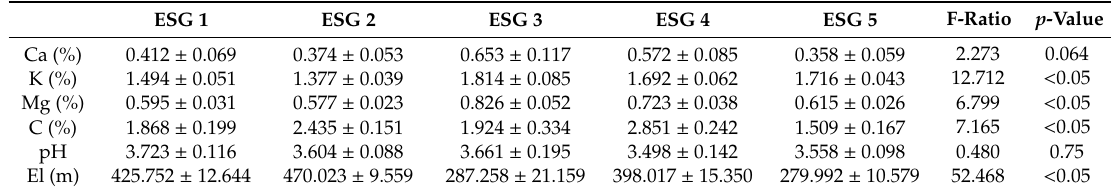
Table 2. Standard deviation of the most important environmental variables between species groups in the study